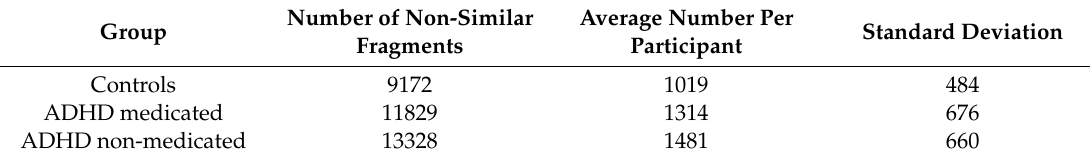
Table 3. Total number of non-similar movement fragments per